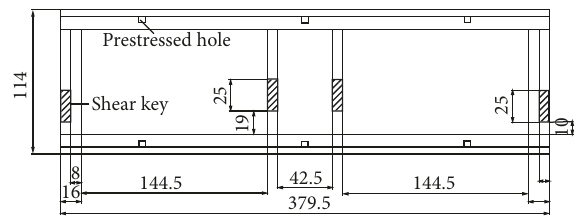
Figure 4: Cross section of the segment joint (mm).